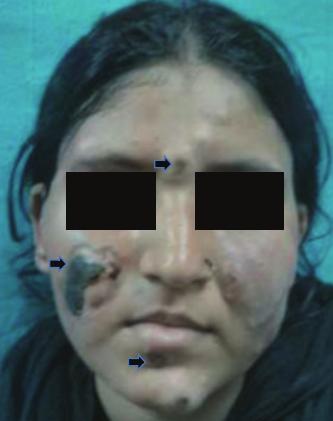
Figure 1: Image of face showing papulonodular lesions over the left cheek and necrotic skin infarct with irregular borders over the right cheek, chin, and forehead (black arrows).